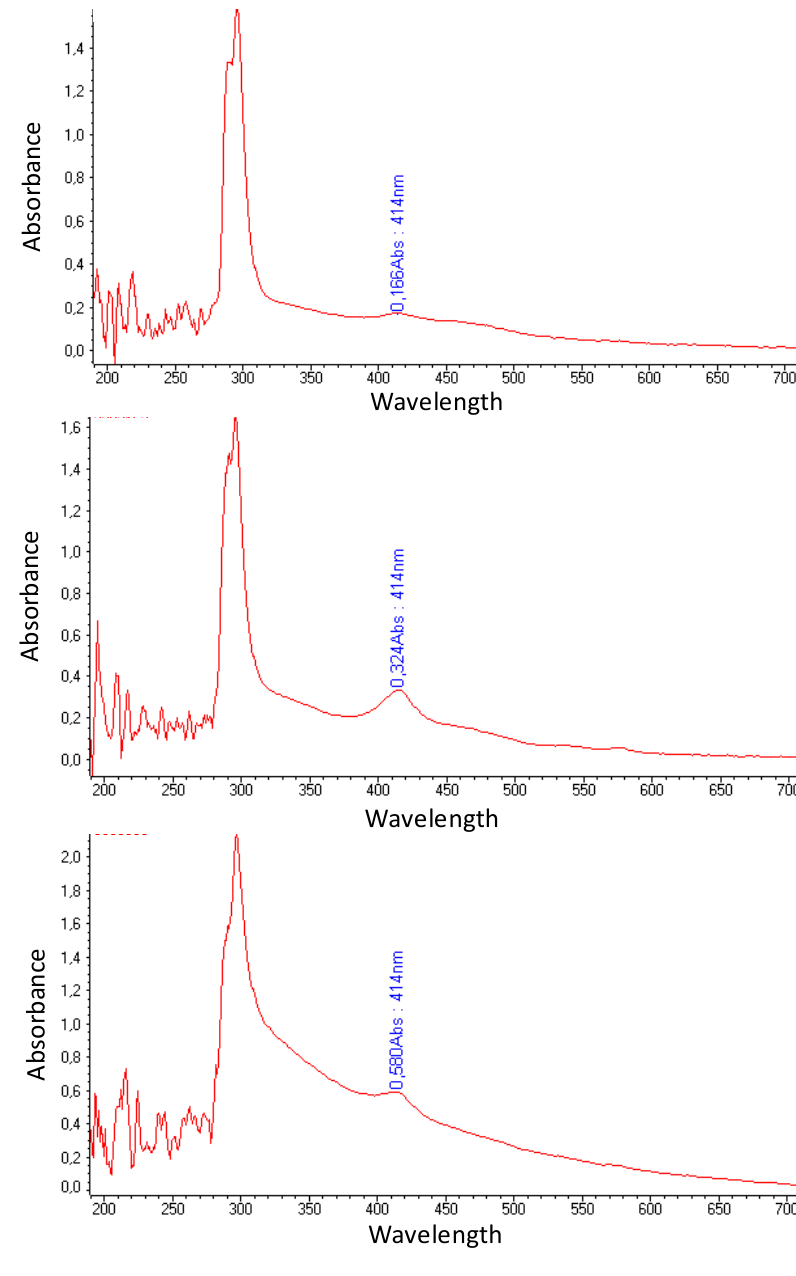
Figure 4. Spectrophotometric measures of haemoglobin (414 nm) of ( A ) a normal, ( B ) a haemolysed and ( C ) a lipemic plasma